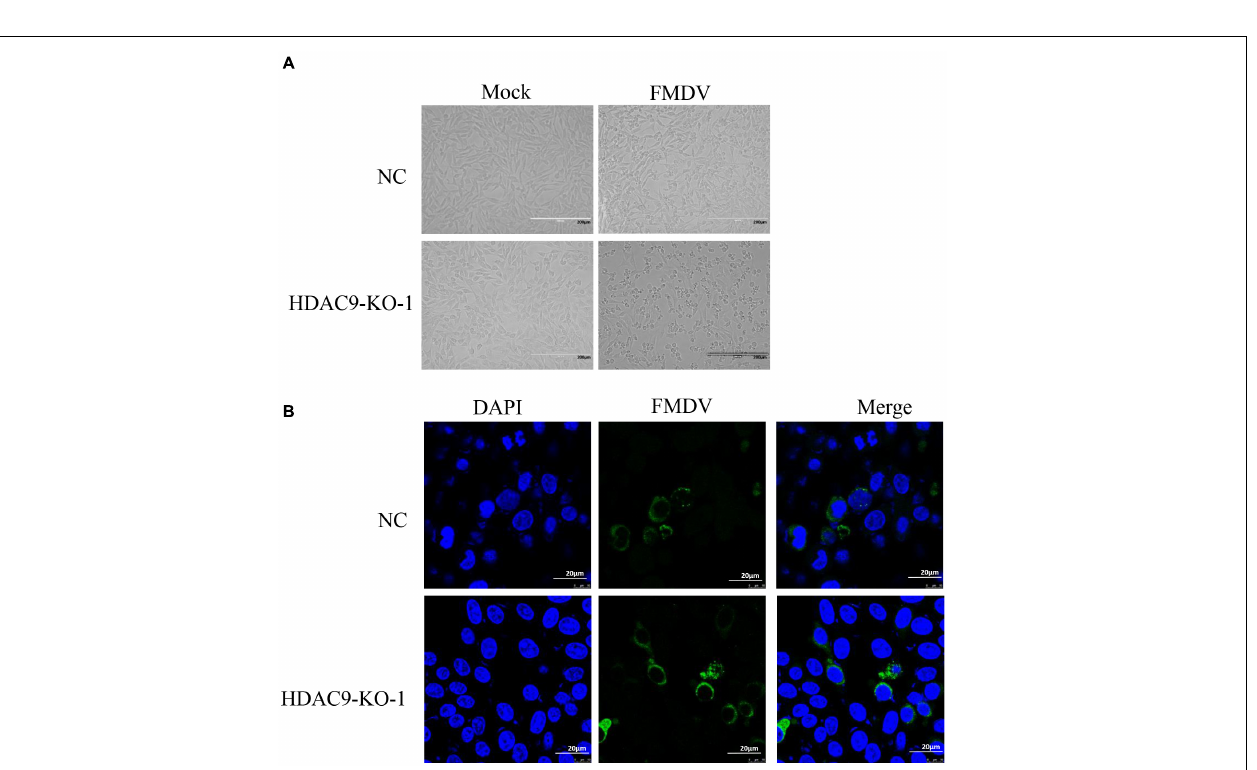
FIGURE 2 | Chromosomal analysis of NC and the HDAC9-KO-1 cell lines. (A) Chromosomes of NC with a diploid number of 42. (B) GTG-banded NC Karyotype. (C) Chromosomes of HDAC9-KO-1 with a diploid number of 42. (D) GTG-banded HDAC9-KO-1 karyotype.